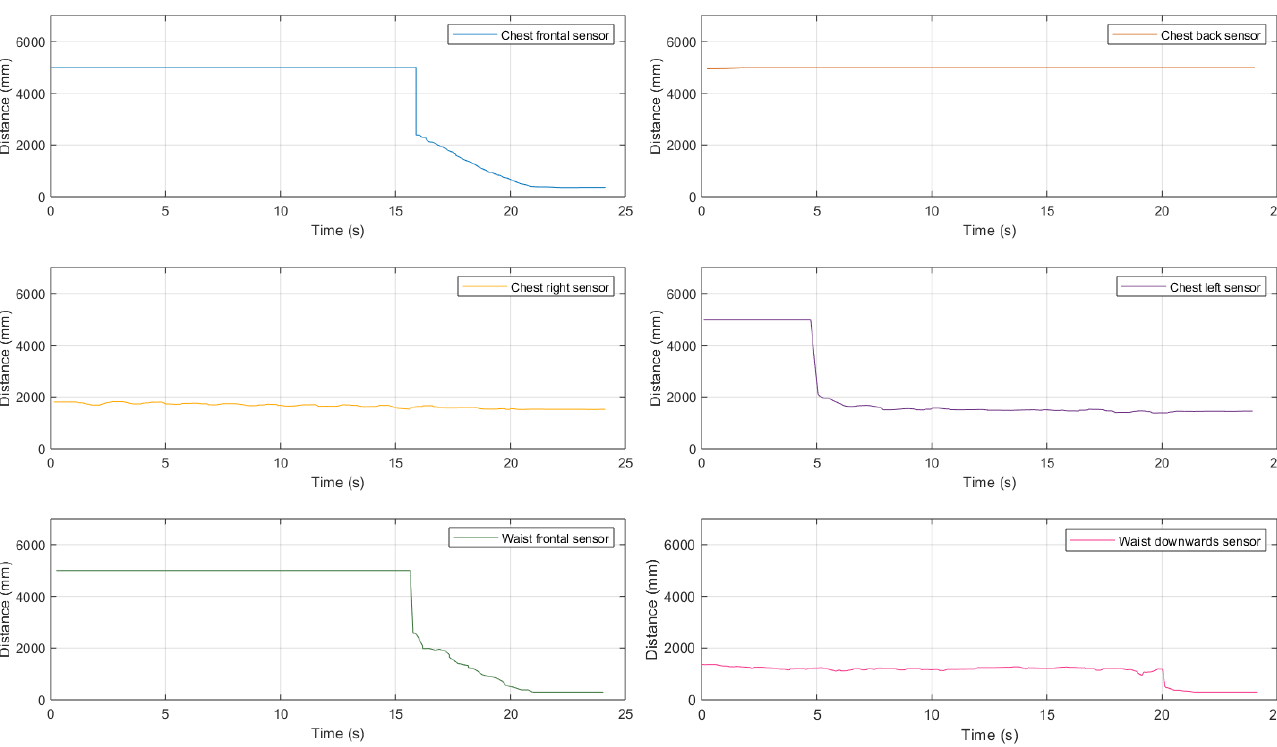
Figure 22. Experimental distance estimates obtained with the configuration shown in Figure 17, in the presence of a stake-shaped obstacle along the